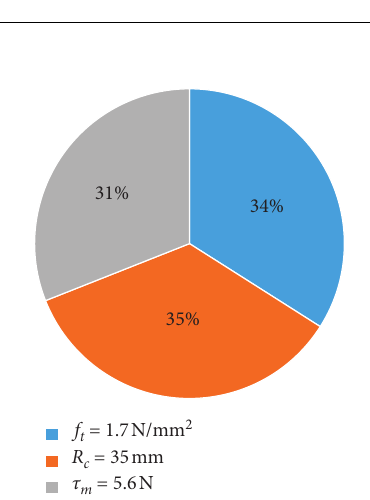
Figure 12: The influence of three variables f concrete crack spacing.